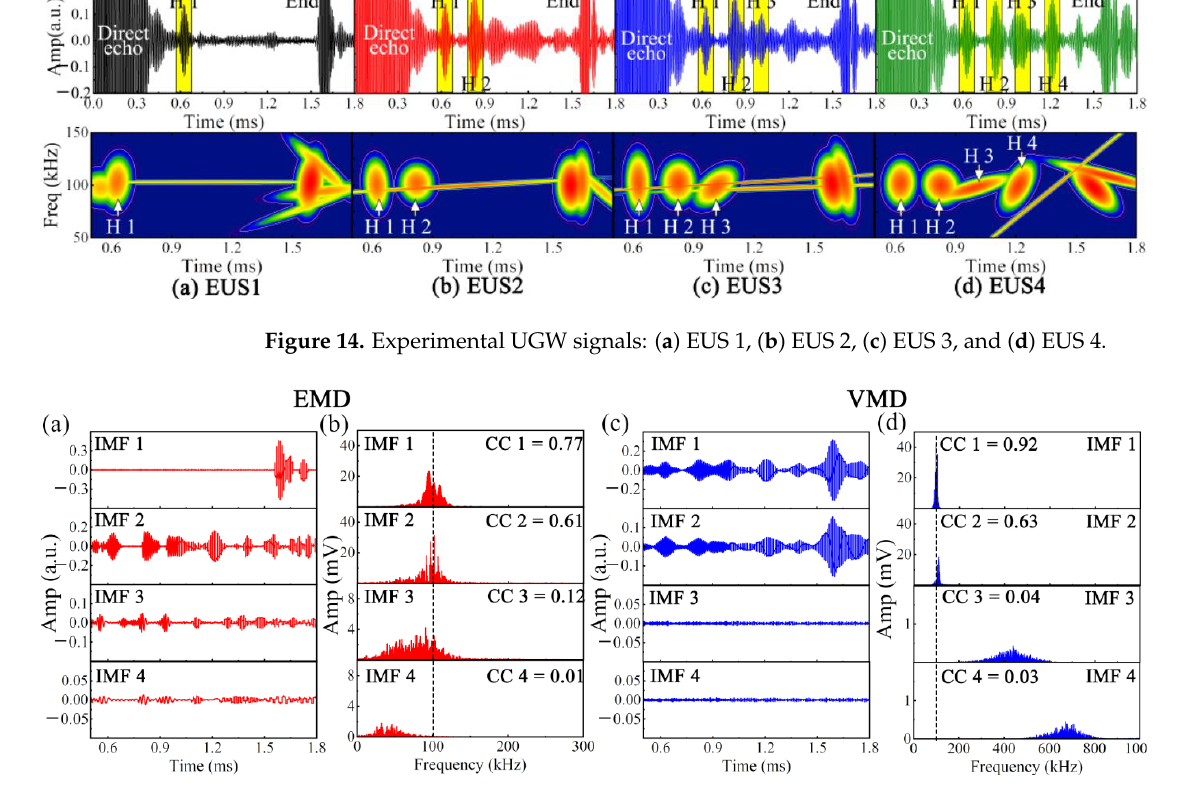
Figure 14. Experimental UGW signals: ( a ) EUS 1, ( b ) EUS 2, ( c ) EUS 3, and ( d ) EUS 4.